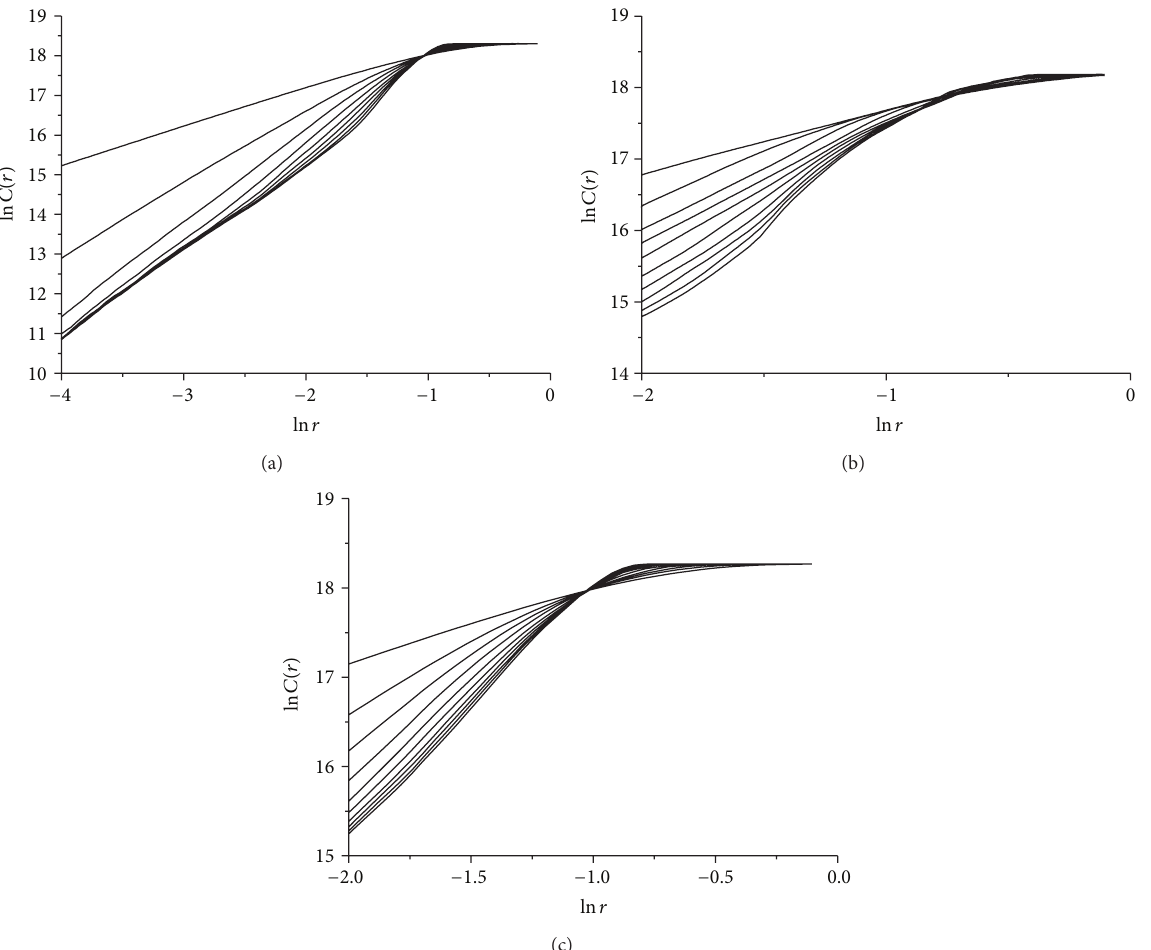
Figure 13: Relation between ln 𝐶(𝑟) and ln 𝑟 for different embedding dimensions 𝑚 for angle 𝛿(𝑡) time-series in the cases of rattlebacks made of (a) wax, (b) gypsum, and (c) lead solder,